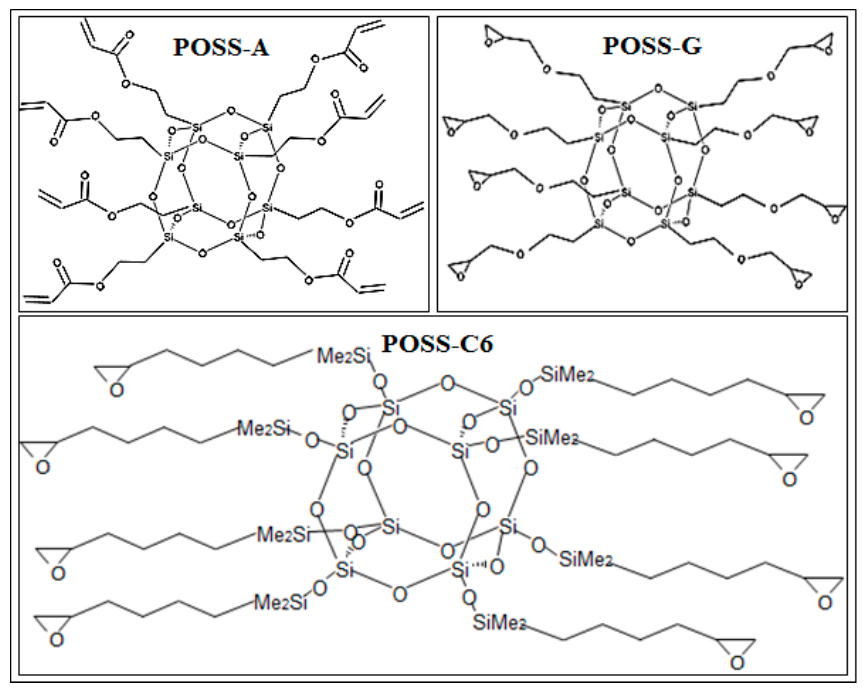
Scheme 2. Structural details of the POSS resists used in the present